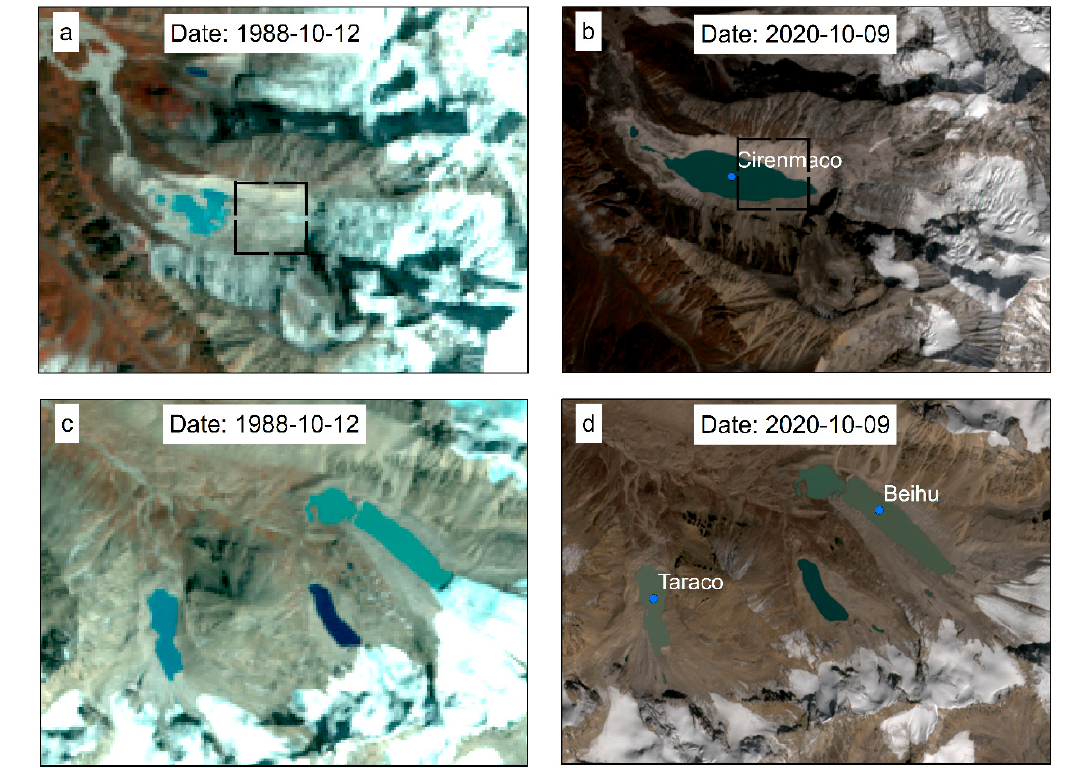
Figure 9. An example of the differences in lake evolution between ( a , b ) Cirenmaco and ( c , d ) Beihu and Taraco.